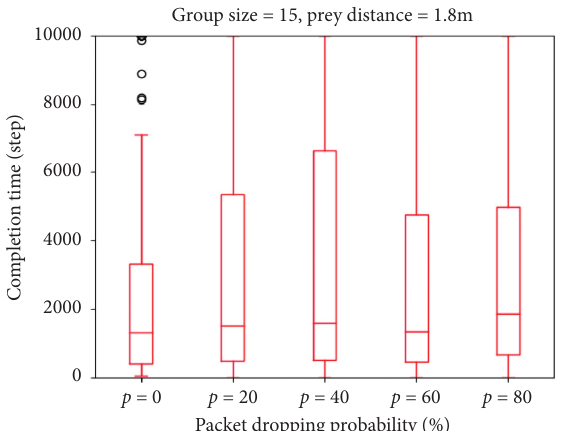
Figure 16: Box-and-whisker plots (Becker et al. 1998 [41]) of robustness tests for the packet dropping probability in the range- and-bearing system (100 observations per box) for a group of 15 robots and a food distance of 1.8m. See Figure 10 for an expla- nation of box-and-whisker plots.